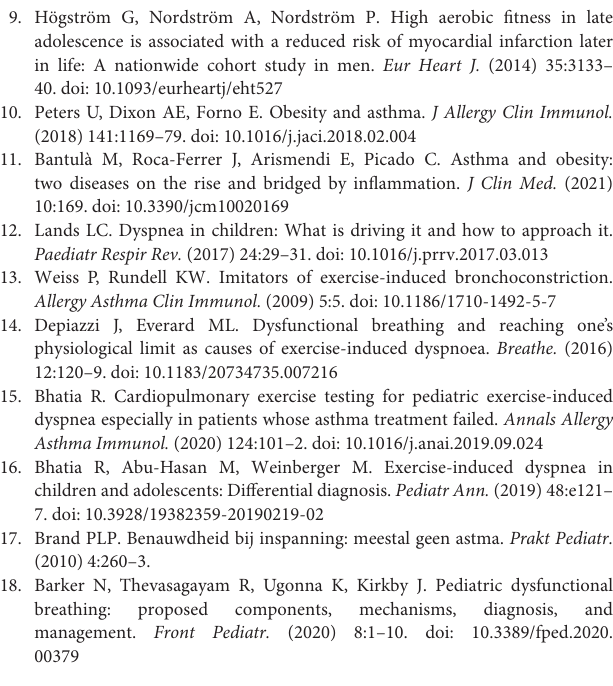
Supplementary Figure 1 | Diagnostic pathway for childhood exertional